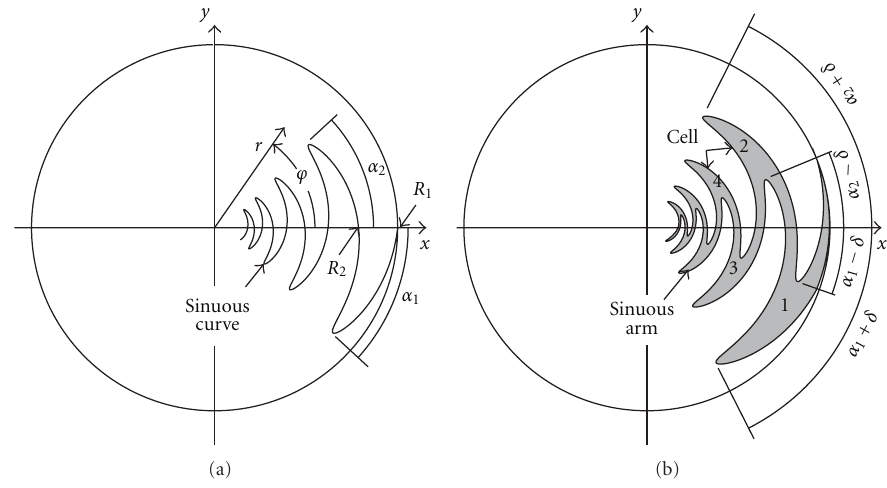
Figure 1: Sinuous curve design and relative parameters.